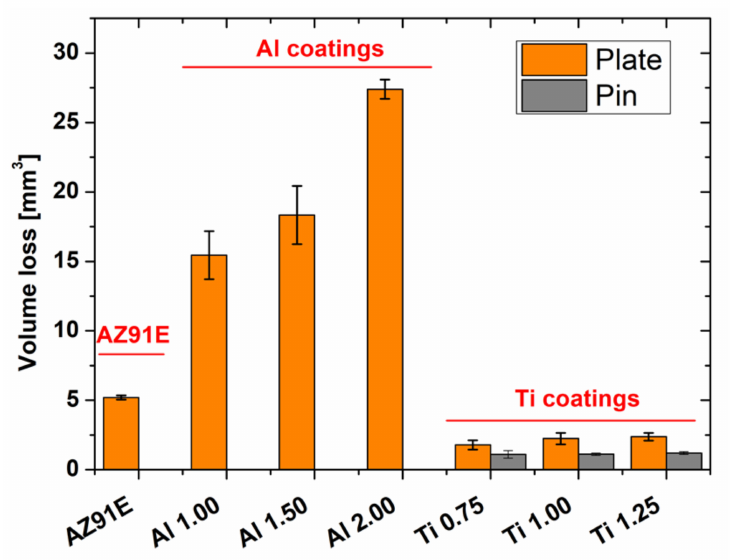
Figure 11. Volume loss of Al and Ti coatings, AZ91E substrate plate and pin material.